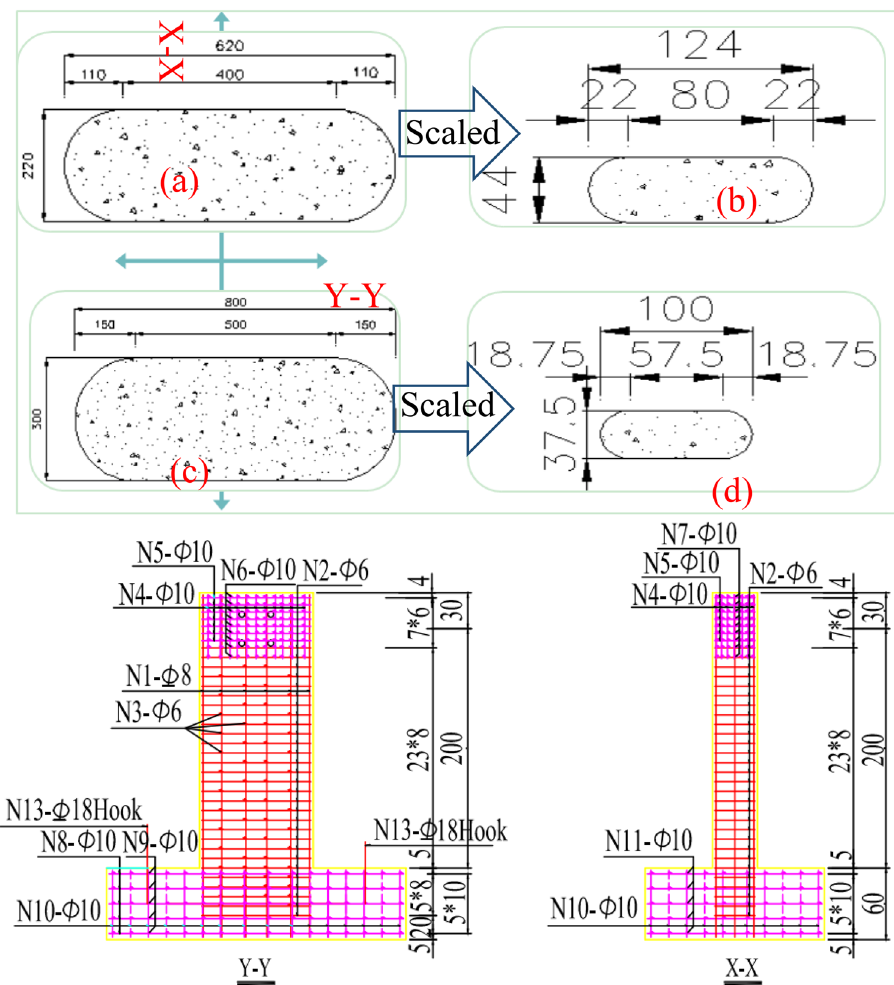
Figure 3. Cross-sections of RERSCSS concrete piers used in HSRB prototype and test model (unit: cm). ( a ) 8 m high pier prototype, ( b ) 8 m high pier model, ( c ) 16 m and 24 m high pier prototype, ( d ) 16 m and 24 m tall pier model.